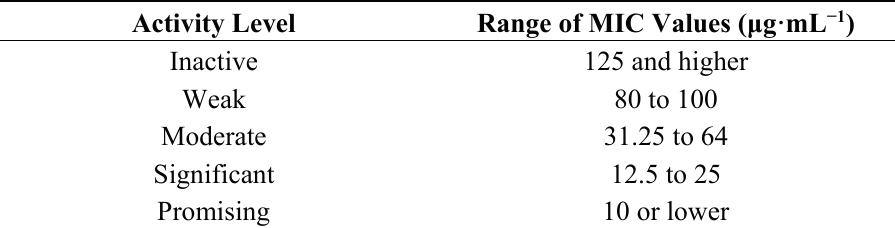
Table 1 : Classification of compounds with anti-mycobacterial activities.